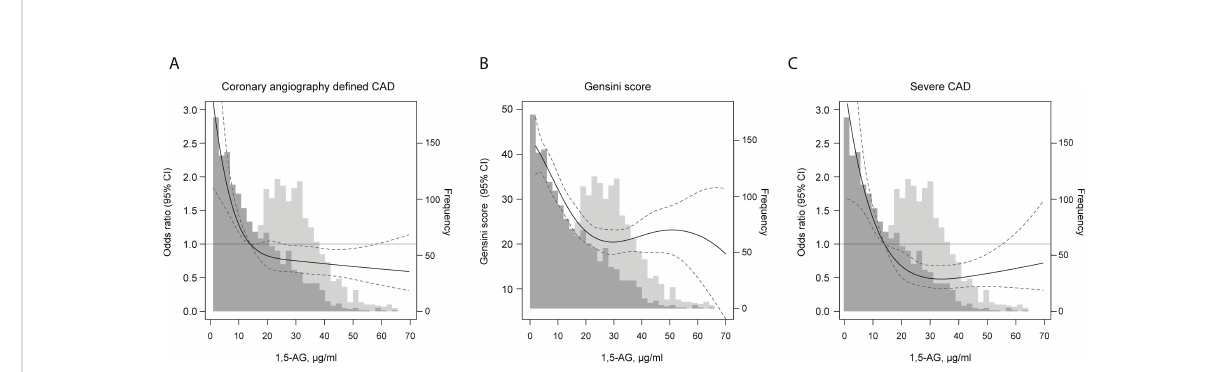
FIGURE 1 Adjusted associations of serum 1,5-AG levels with (A) coronary angiography de fi ned CAD, (B) Gensini scores and (C) severe CAD in the BHAS study, N = 2945. 1,5-AG was modeled using restricted cubic splines (solid line) with knots at the 5th, 27.5th, 50th, 72.5th, and 95th percentiles. The concentration of 1,5-AG of 14 m g/mL was used as the reference point for (A) and (C) . 95% CIs are shown with the dashed lines. Models are adjusted for age, gender, current smoker, obesity or overweight, diabetes, hypertension, dyslipidemia, stroke and family history of premature CAD. Frequency histograms are shown for persons without diabetes (light gray bars) and for persons with diabetes (dark gray